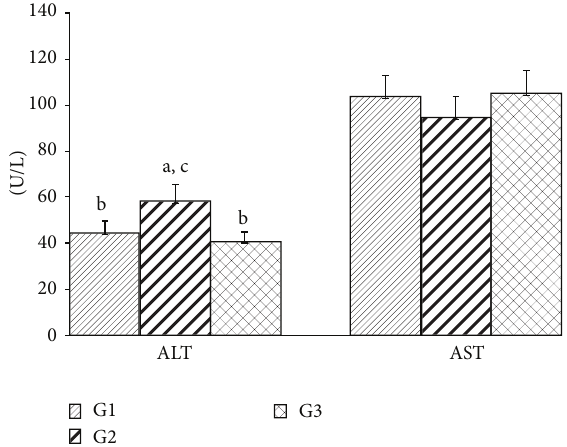
Figure 3: Serum activity of ALT and AST after 30 days for all experimental groups. Values are given as the mean ± SD for each group of eight animals. a Significantly different from G1; 𝑃 ≤ 0.05 ; b significantly different from G2; 𝑃 ≤ 0.05 ; and c significantly different from G3; 𝑃 ≤ 0.05 . G1: untreated control; G2: treated with geraniol; and G3: treated with essential oil.